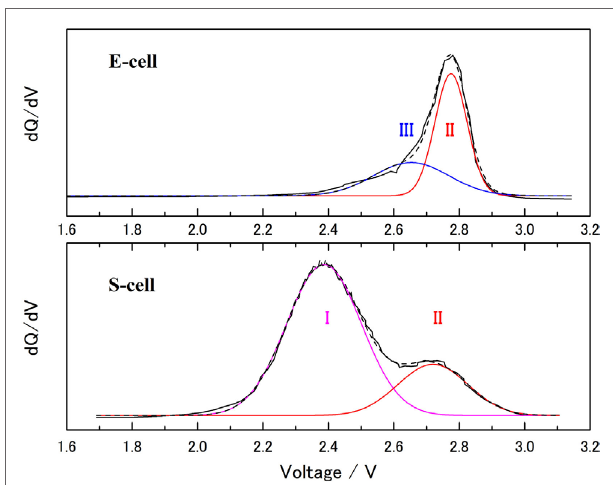
FigUre 9 | dQ/dV plot of the charge process for s-cell (bottom) and e-cell (upper) . Gaussian peak fitting was performed onto the dQ/dV data with R 2 > 0.998. Each peak consists of I: main red-ox reaction of sulfur, II: red-ox capacity with poly-condensation of Li3PS4, and III: red-ox capacity of